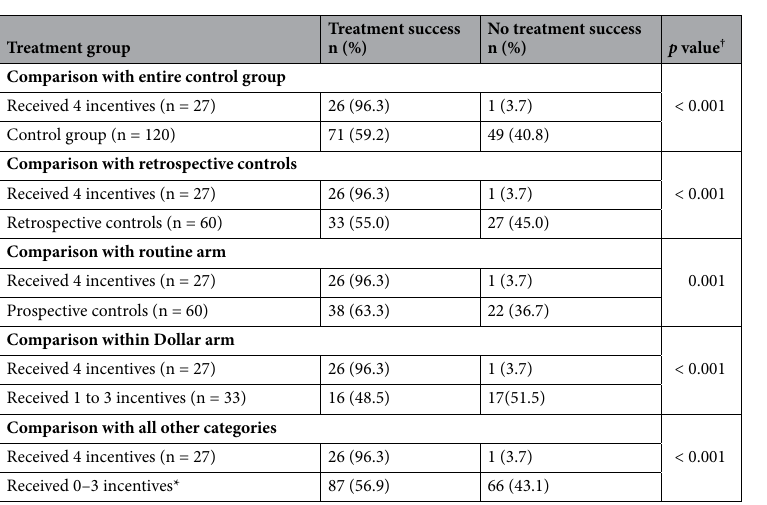
Table 5. Comparison of treatment success between participants who received all four incentives and other sub-groups. *Includes control group and participants who received < 4 incentives in the dollar arm. † Fisher’s exact